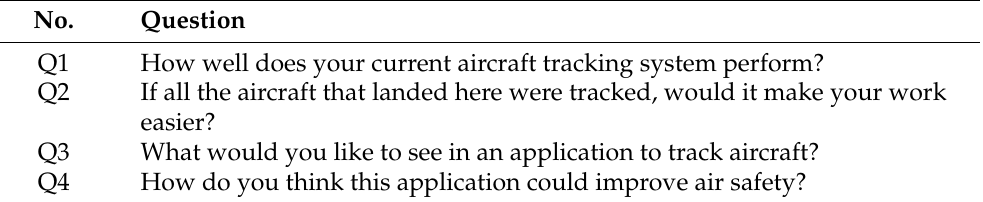
Table 4. Interview questions with the radio